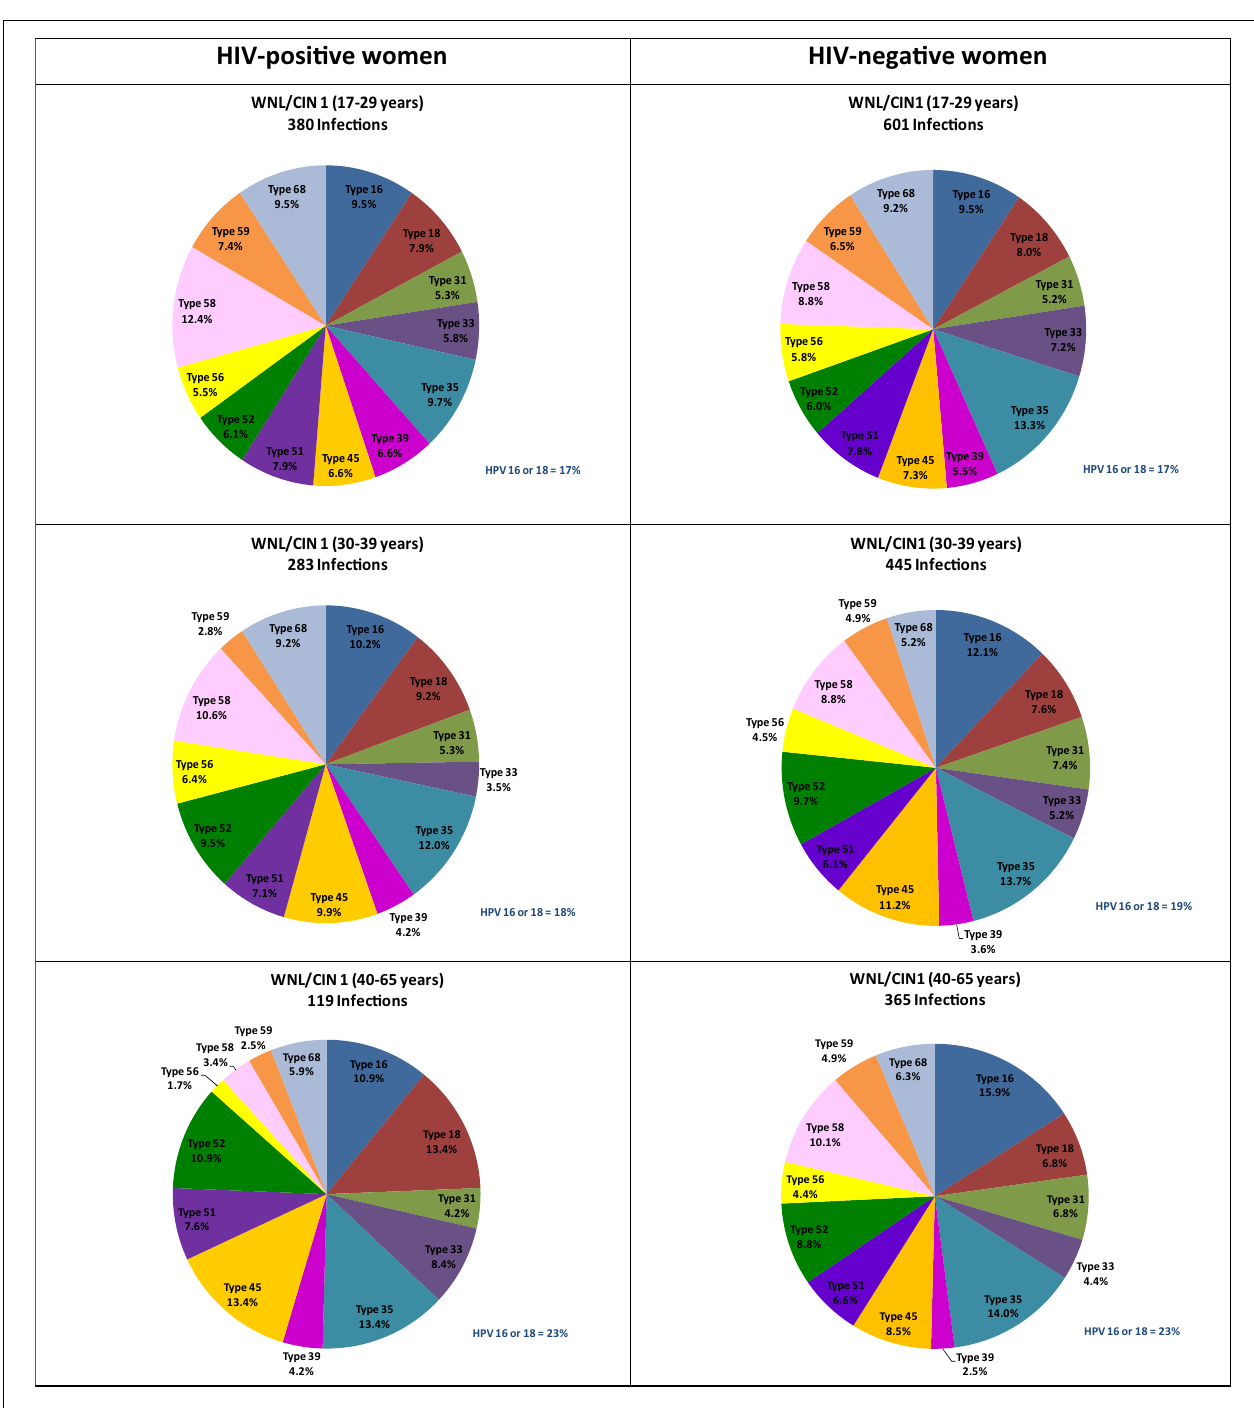
FIGURE 2 |Age-specific distribution of high-risk HPV genotypes of 782 infections among 492 HIV-positive women and 1,411 infections among 1,074 HIV-negative women with within normal limits or cervical